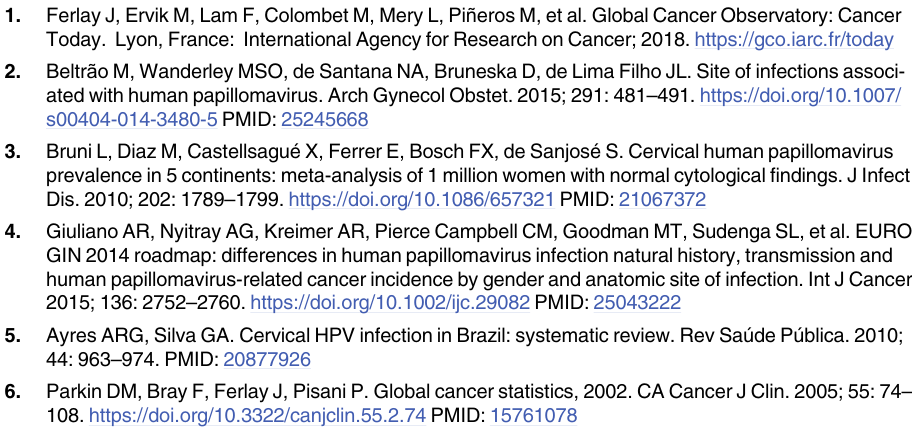
S1 Table. Characteristics of studies included in the systematic review. S2 Table. Assessment of bias risk. S1 Fig. Funnel plot of the studies that measured the prevalence of (a) cervical, (b) penile, (c) anal and (d) oral region. S2 Fig. Overall prevalence of cervical HPV in Brazil. S3 Fig. Sub-group analysis of prevalence high-risk HPV genotypes in Brazil, by